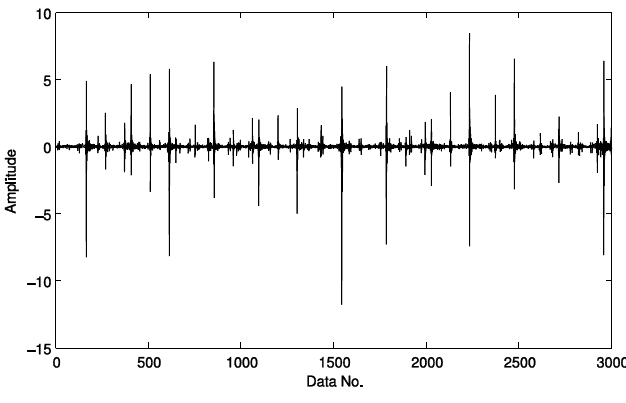
Figure 9. Vibration waveform of a bearing with an inner race fault.